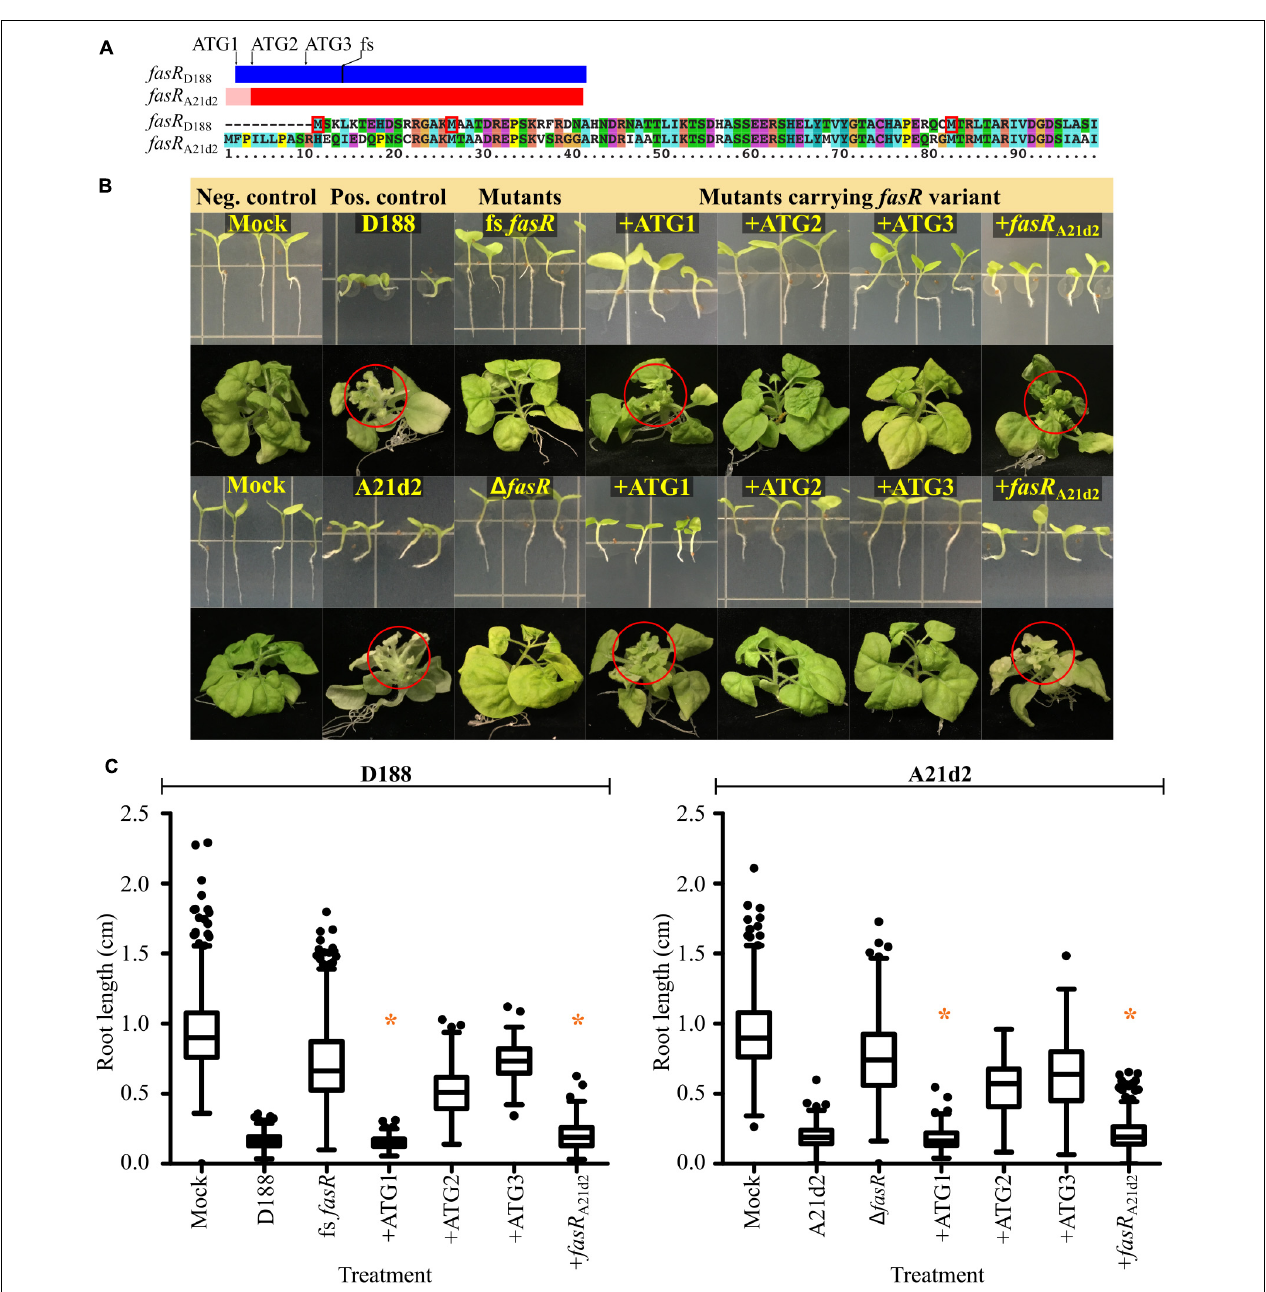
FIGURE 2 | The fasR gene is necessary for virulence of D188 and A21d2. (A) Scaled schematic of the fasR coding sequences of D188 (blue) and A21d2 (red). The first three in-frame ATG codons of fasR D188 are shown. The location of the single base insertion introduced to cause a frameshift (fs) in fasR D188 is also indicated. A possible 5 (cid:48) extension to fasR A21d2 is depicted by a pink-colored box. An alignment of the first ∼ 100 amino acids of the FasR variants of D188 and A21d2 is shown below the schematic. The first three methionine residues of FasR of D188 are boxed in red. (B) Wild type and mutant strains of D188 and A21d2 were inoculated onto seedlings or meristems of N. benthamiana. Red circles circumscribe leafy galls. Images of representative plants are shown. This is a composite figure in which photographs were taken of plants treated in different experiments. Images of representative plants are shown. In all experiments, positive and negative control treatments were included. (C) At 7 dpi, roots were imaged and measured. Differences were compared relative to the corresponding D188 or A21d2 control groups (* is not significant with a p -value threshold ≤ 0.05). Similar results were reproduced in at least two additional repeats of the experiments.